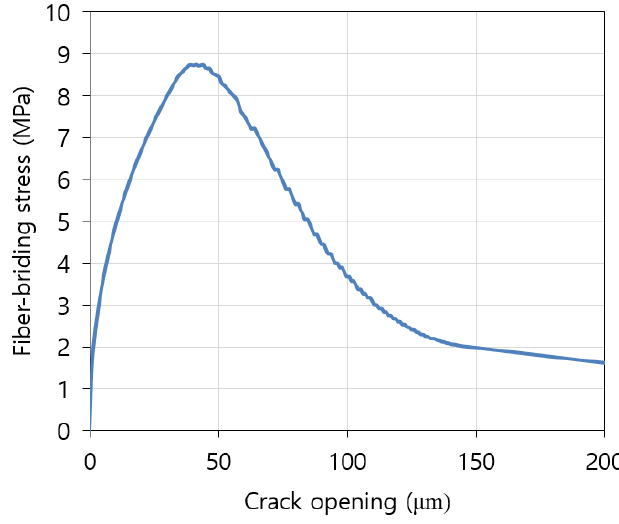
Figure 9. Theoretical fiber-bridging curve of composite.